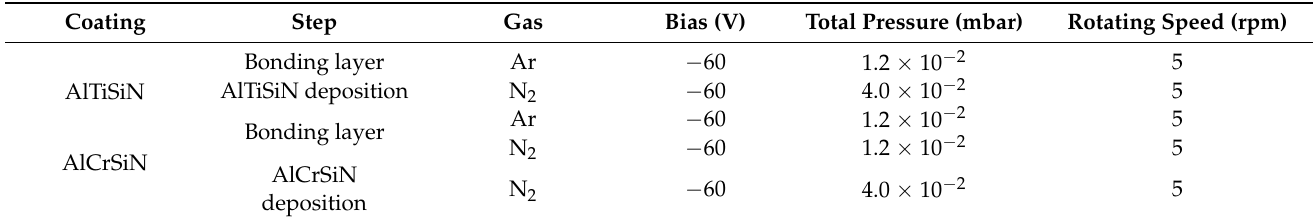
Table 3. The deposition parameter of AlTiSiN and AlCrSiN